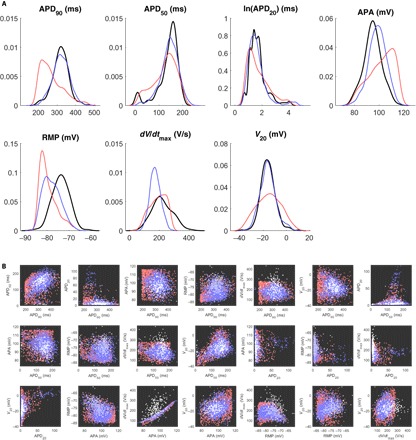
Calibration to biomarker distributions as opposed to their ranges reduces model bias.(A) Marginal distributions of the biomarkers in the SR data set (black) and POMs calibrated to biomarker distributions using the SMC algorithm (blue) or calibrated to biomarker ranges using LHS (red). The natural logarithm of APD20 values is used to better display their distribution. SMC for distributional calibration is seen to provide a significant improvement in agreement with the data. (B) Pairwise scatterplots of each unique pair of biomarkers in the SR data set (white) and the POMs constructed using SMC matched to distributions (blue) and LHS matched to ranges (red). The SMC-generated POM demonstrates good localization to the dense regions in the data but requires further calibration. An obvious correlation between APA and dV/dtmax is exhibited by the model, regardless of the sampling method used, but this correlation is not present in the data.